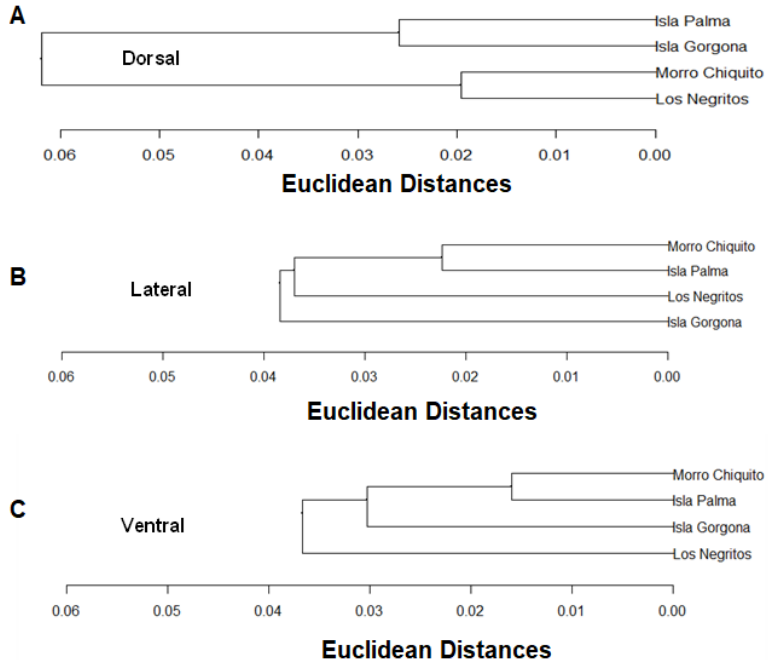
Figure 4. Dendogram of similarity of the Euclidean distances in the views ( A : Dorsal, B : Lateral and C : Ventral) in Málaga Bay and Gorgona Island.